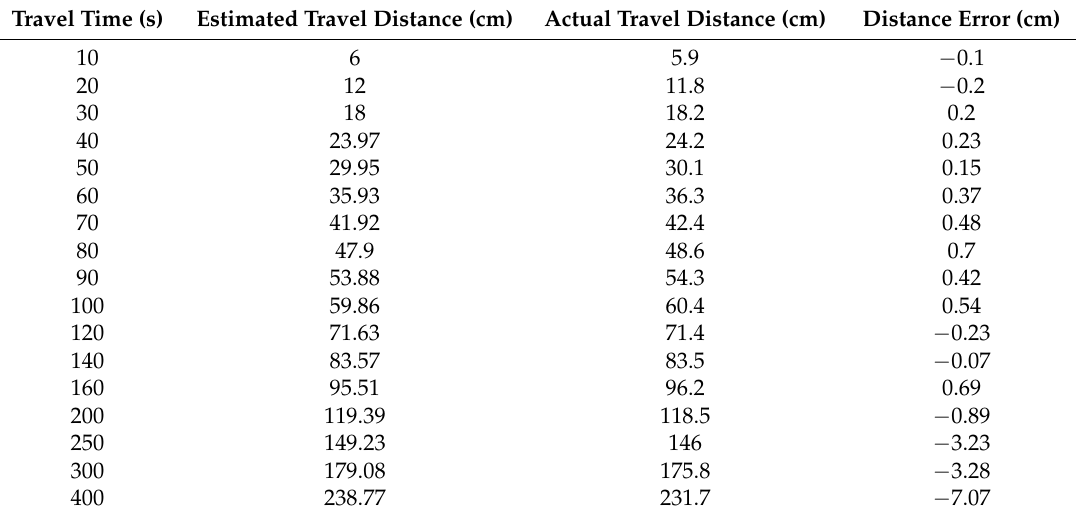
Table 4. Comparison of travel distance after